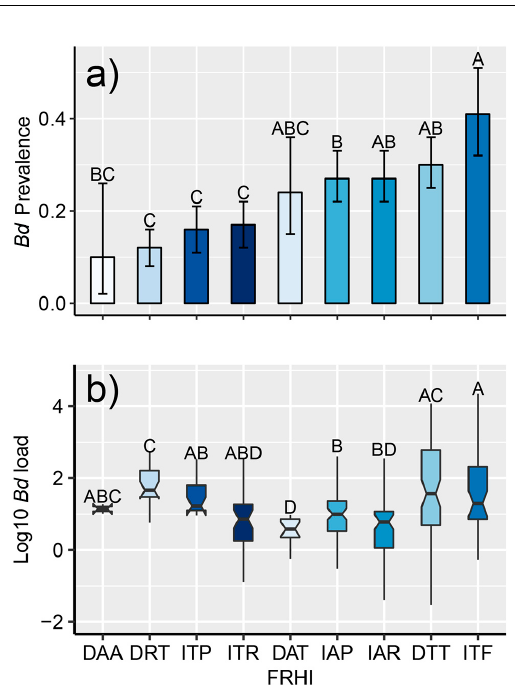
Figure 4. ( a ) Mean prevalence of infection with Batrachochytrium dendrobatidis (Bd) in amphibian assemblages (with 95% binomial CI) according to the foraging–reproduction habitat index (FRHI); ( b ) box plots with whiskers and notches that describe infection intensity for the 351 individuals where Bd was quantified using qPCR in Costa Rica between 2000–2018 according to the foraging–reproduction habitat index (FRHI). The box displays the inter-quantile range (25th–75th percentiles) with a center line representing the median (50th percentile). Notches show the median confidence region, and whiskers display the highest and lowest points. Means followed by a common letter are not significantly different according to the Tukey’s honestly significant difference (HSD) test at the 5% level of significance. Symbology: First letter represents development: (I) indirect or (D) direct- developing amphibians. Second letter represents foraging habitat: terrestrial (T), arboreal (A), pond/puddle-dwellers (P), stream-breeders (R), and phytotelma (F). Third letter represents reproductive habitat: terrestrial (T), arboreal (A), pond/puddle-dwellers (P), stream-breeders (R), and phytotelma (F). Table 4. Infection intensity in the 351 individuals where Batrachochytrium dendrobatidis ( Bd ) was quantified using qPCR in Costa Rica between 2000–2018. For every species, the table shows the foraging–reproduction habitat index (FRHI), the number of Bd positive swabs, the average (SE), and log 10 (SE) of genomic equivalents of Bd zoospores quantified per species estimated from the Bd + swabs. Symbology: First letter represents development: (I) indirect or (D) direct-developing amphibians. Second letter represents foraging habitat: terrestrial (T), arboreal (A), pond/puddle- dwellers (P), stream-breeders (R), and phytotelma (F). Third letter represents reproductive habitat: terrestrial (T), arboreal (A), pond/puddle-dwellers (P), stream-breeders (R), and phytotelma (F). Species (FRHI)